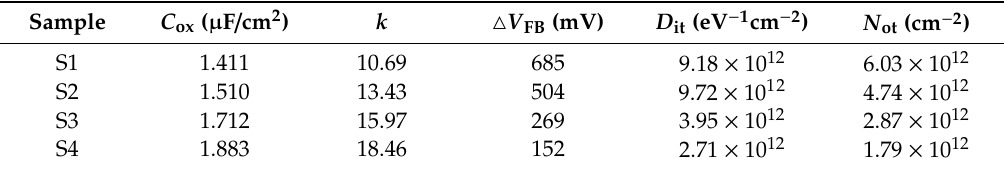
Table 1. The electrical parameters extracted from the fabricated MIS capacitors without and with La 2 O 3 interfacial passivation layers.